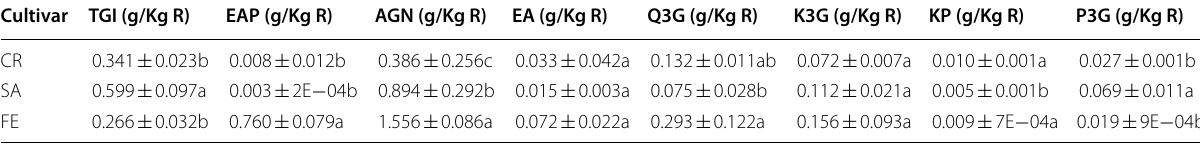
Different lowercase letter indicates significant differences ( p < 0.05) by Tukey’s test among cultivars CR camino real, SA San Andreas y, FE festival, TGI tetragalloyl‑glucose isomer, EAP ellagic acid pentoside, AGN agrimoniin, EA free ellagic acid, Q3G quercetin‑3‑ O ‑ glucuronide, K3G kaempferol‑3‑ O ‑glucuronide, KP kaempferol pentoside, P3G pelargonidin‑3‑glucoside